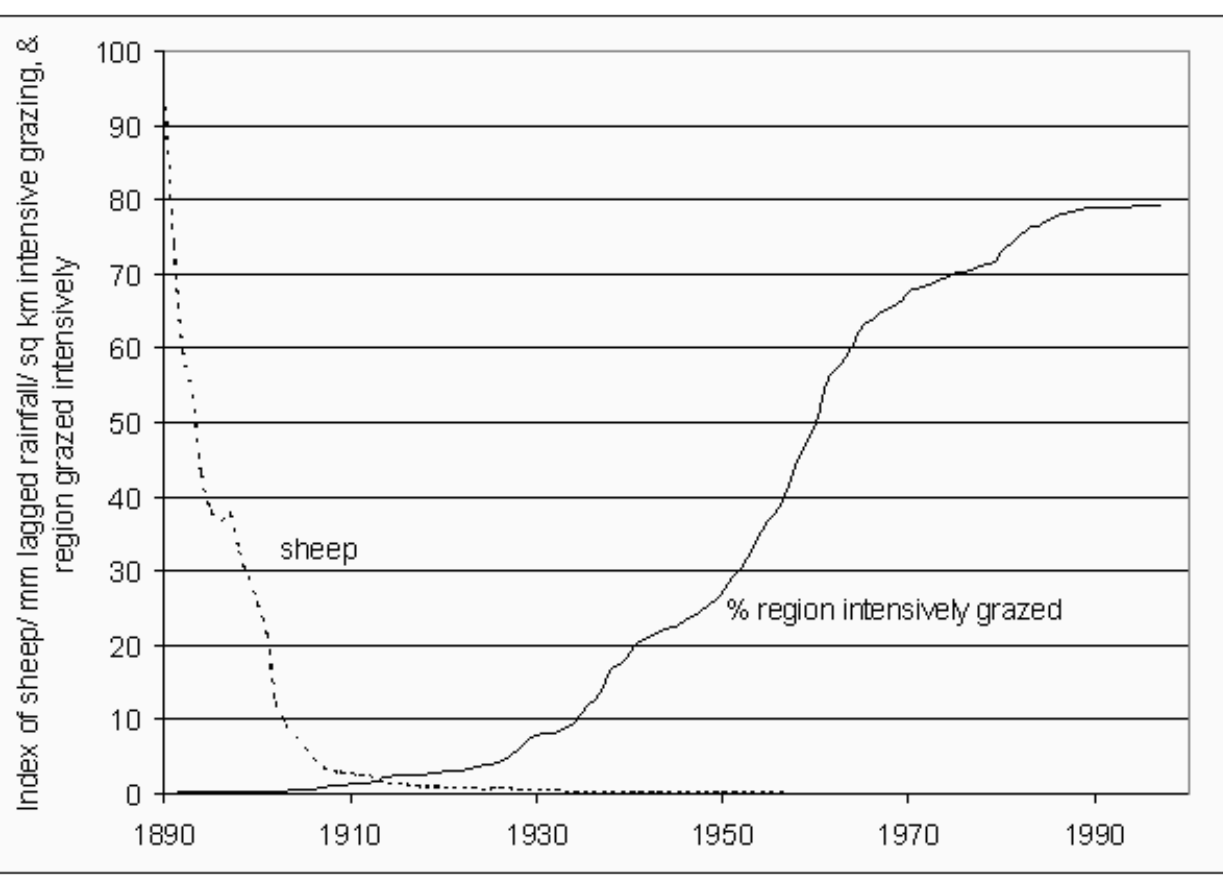
Fig. 7 . Effect of artificial water on intensity of grazing in New South Wales, Australia. The dotted line represents a 5-yr running mean of the index of sheep number/mm of rainfall lagged over the previous 2 yr/ km² of land within 2 km of artificial water. The continuous line represents the percentage of the region within 2 km of artificial